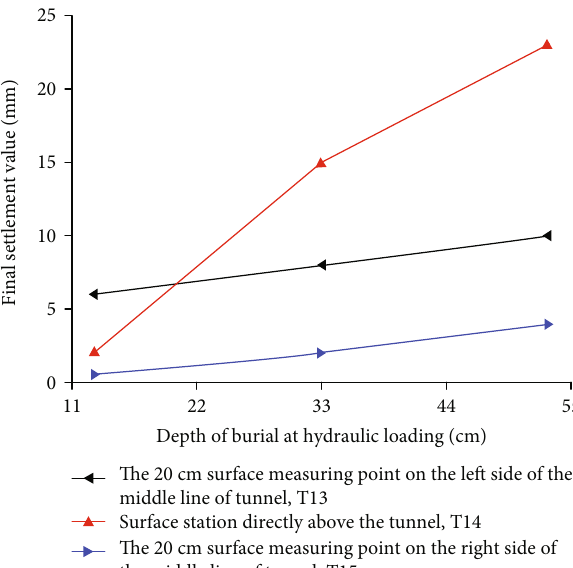
The 20 cm surface measuring point on the left side of the middle line of tunnel, T13 Surface station directly above the tunnel, T14 The 20 cm surface measuring point on the right side of the middle line of tunnel, Figure 9: Surface settlements in di ff erent conditions of seepage